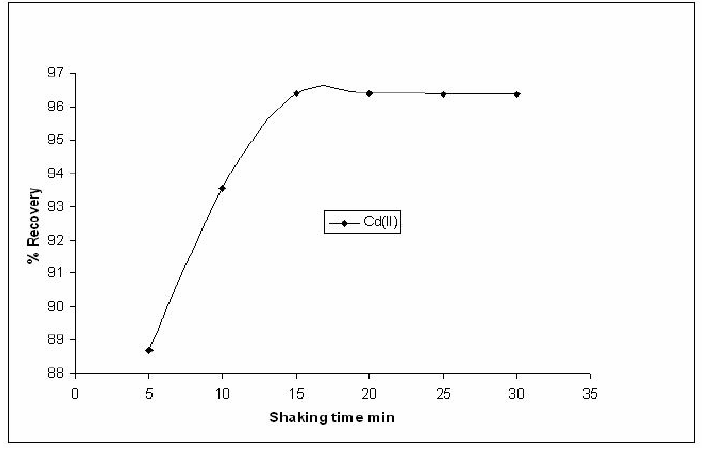
Figure 7. Extraction percentage of Cd(II) at different shaking